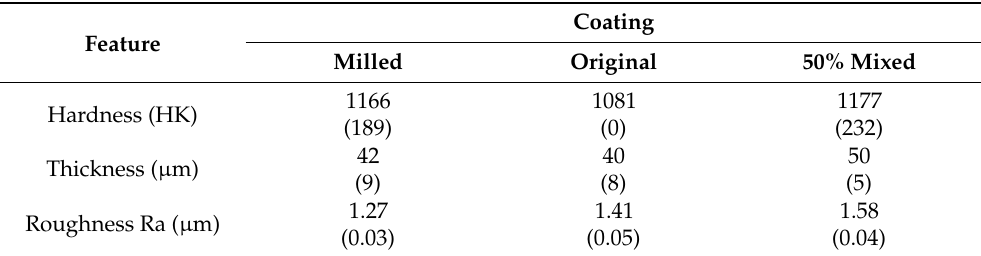
Table 2. The coatings’ properties. Standard deviations are shown in parenthesis.